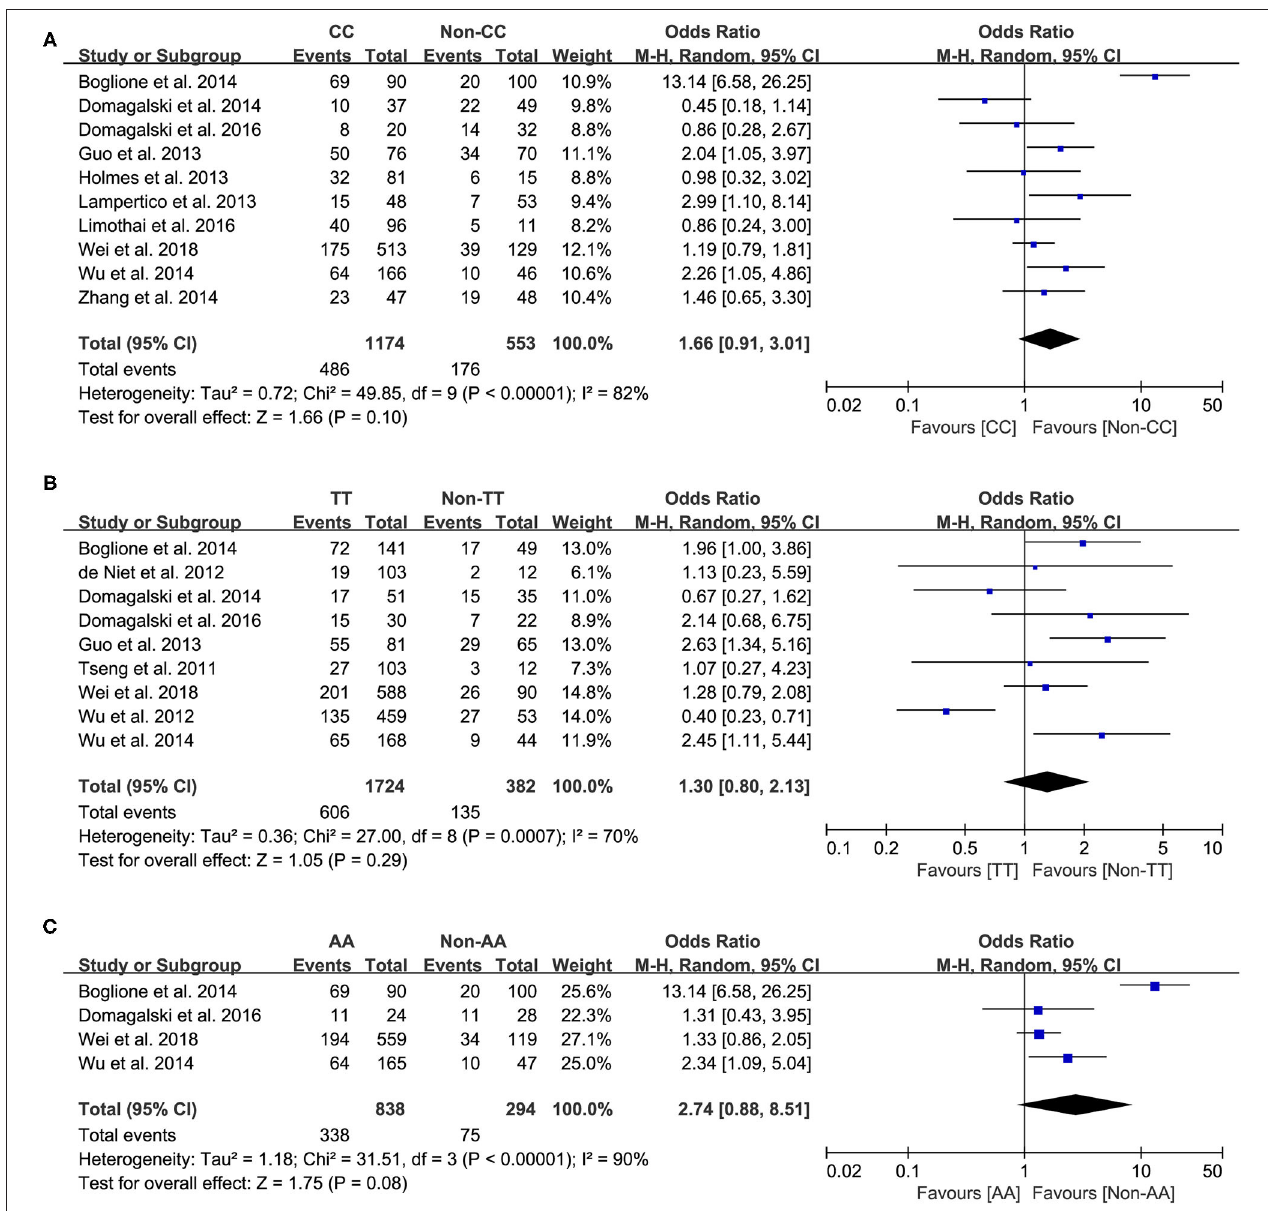
FIGURE 3 | Forest plots for the association between IL-28B polymorphisms and treatment response of HBV infected patients treated with PEG-IFN. (A) overall analysis of rs12979860; (B) overall analysis of rs8099917; (C) overall analysis of rs12980275. HBV, hepatitis B virus; PEG-IFN, pegylated interferon.